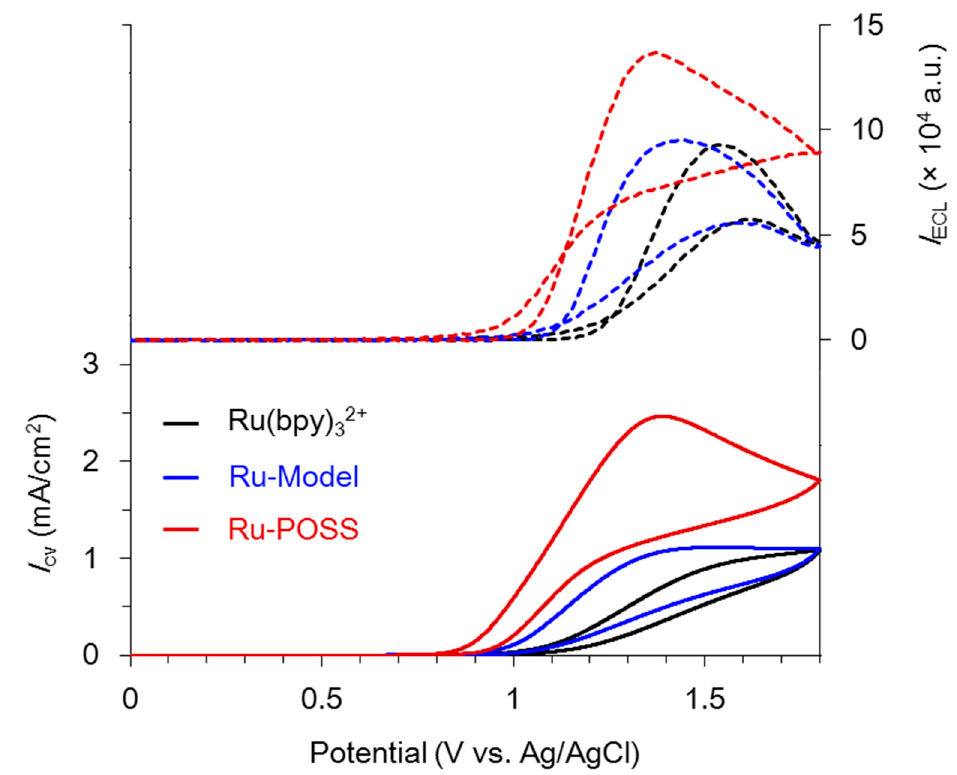
Figure 2. Cyclic voltammograms (solid lines) and corresponding ECL profiles (dashed lines) of 0.1 mM Ru(II) complexes and 100 mM TPrA in 0.20 M PBS bu ff er (pH 8.8) with an ITO electrode at a scan rate of 100 mV / s ( n = 3). The concentration of Ru-POSS was based on the Ru(II) complex